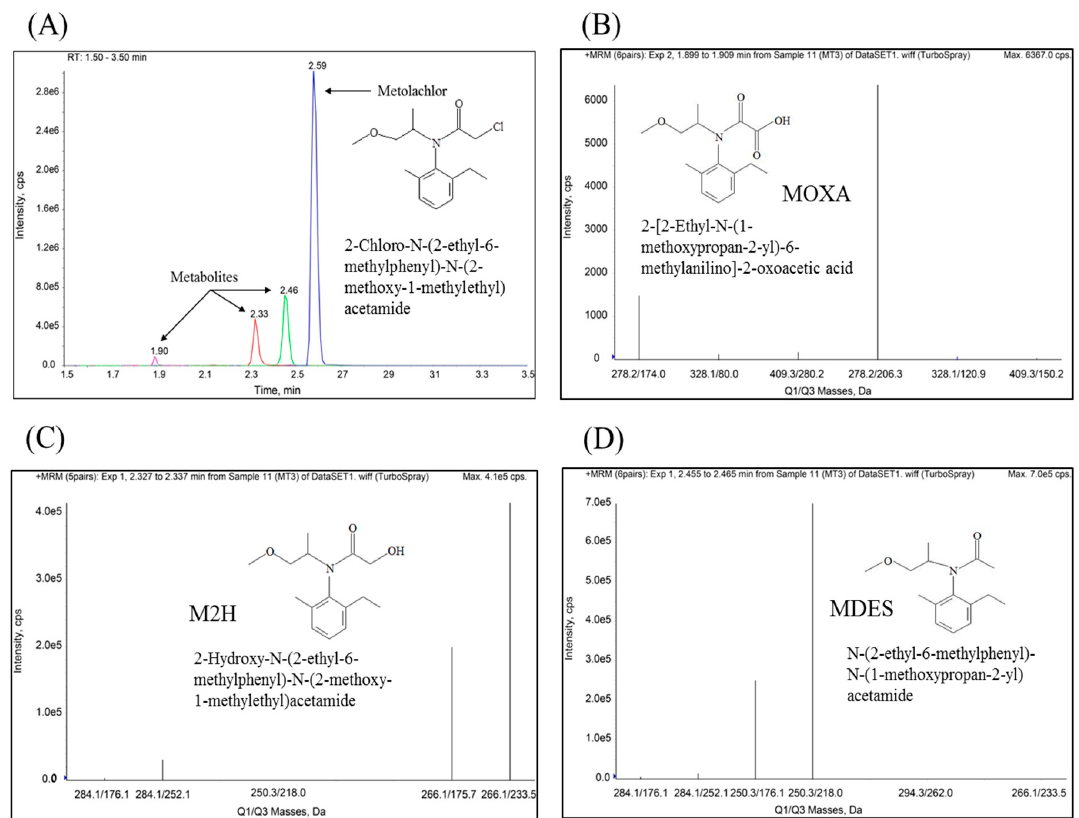
Figure 5. The total ion chromatogram ( A ) and characteristic ions of metabolites (MOXA, M2H, and MDES, ( B – D )) of the liquid sample extracted from the culture of the treatment MFGY at 384 h of incubation. MFGY, MSM inoculated with strain MET-F-1and added with 0.1% glucose plus 0.1% yeast extract.